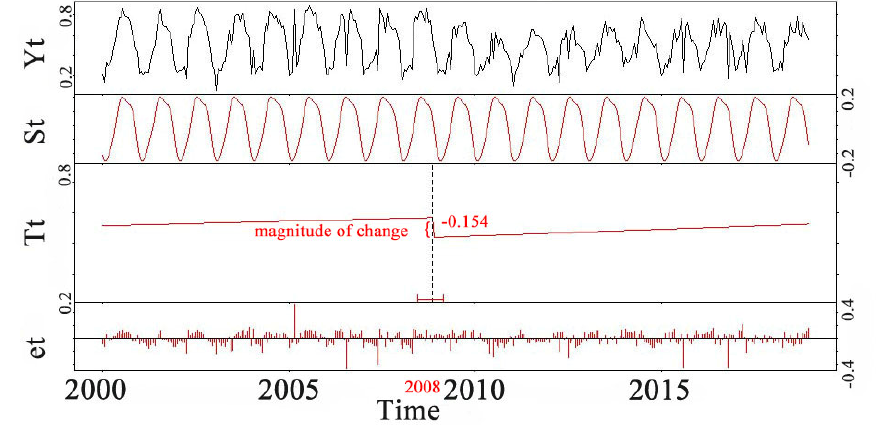
Figure 3. BFAST detected that one breakpoint and a negative magnitude occurred in 2008 in the time- series normalized difference vegetation index (NDVI) during